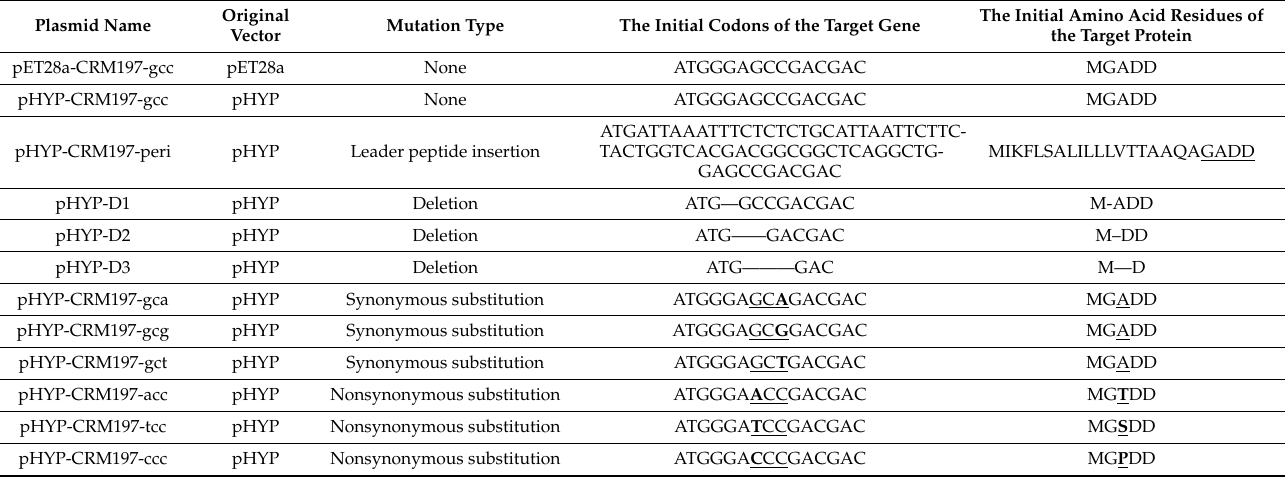
Table 3. Plasmids and variants of the CRM197-encoding gene used in the present work 1